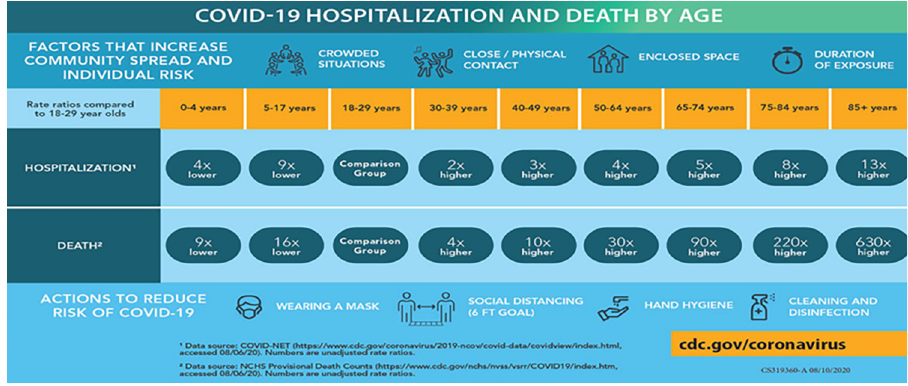
Fig 1. Centers for disease control graph describing COVID-19 hospitalization and death by age [29].